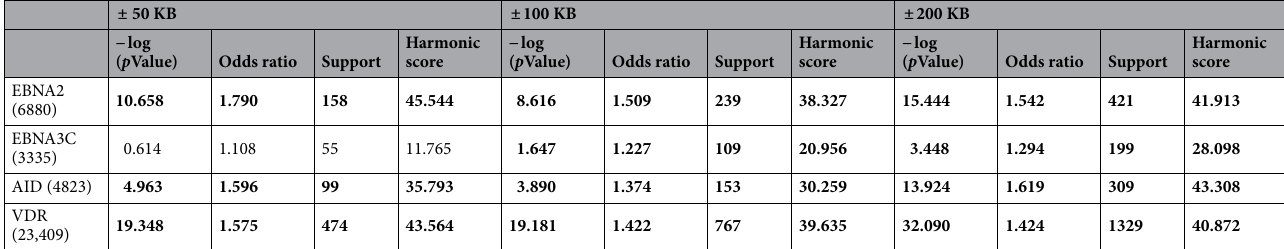
Table 2. Enrichment of MS-GWAS regions (at ± 50,100,200 kb range of extension) in lists (number in brackets in the right-most column) of DNA binding sites of human and viral molecular transducers; significant results ( p < 0.05, corresponding to a − log ( p ) > 1.301) in